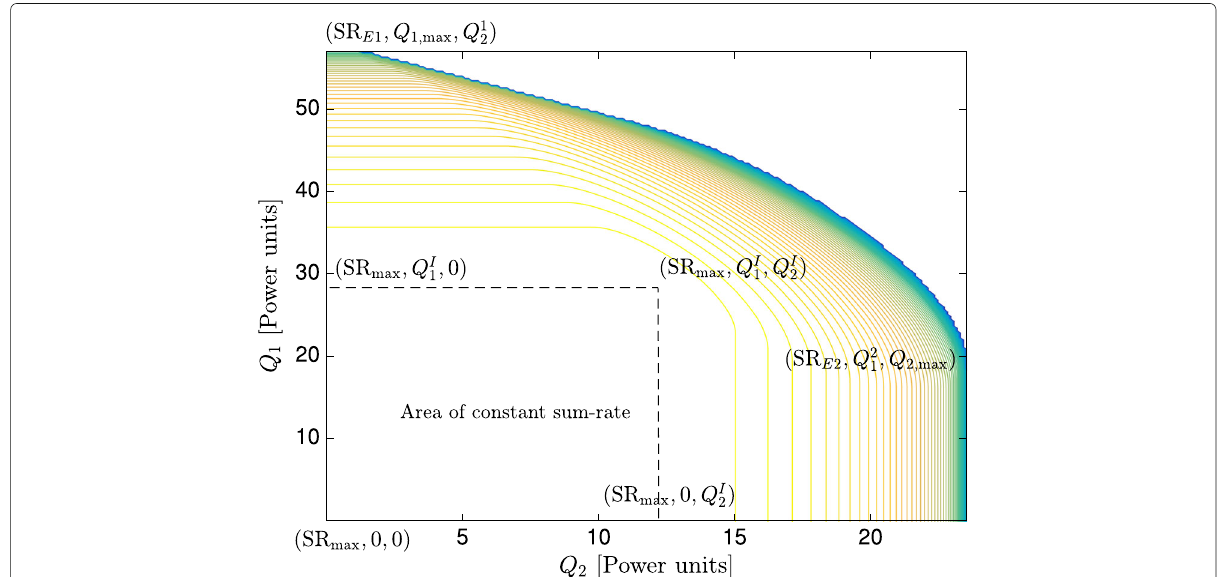
Fig. 3 Contour lines of the three-dimensional R-P region. Contour lines of the three-dimensional R-P region of problem (13). Note that the density of lines increases with the gradient of the surface, and the color indicates the value of such a surface. Note also that some important boundary characteristic points have been